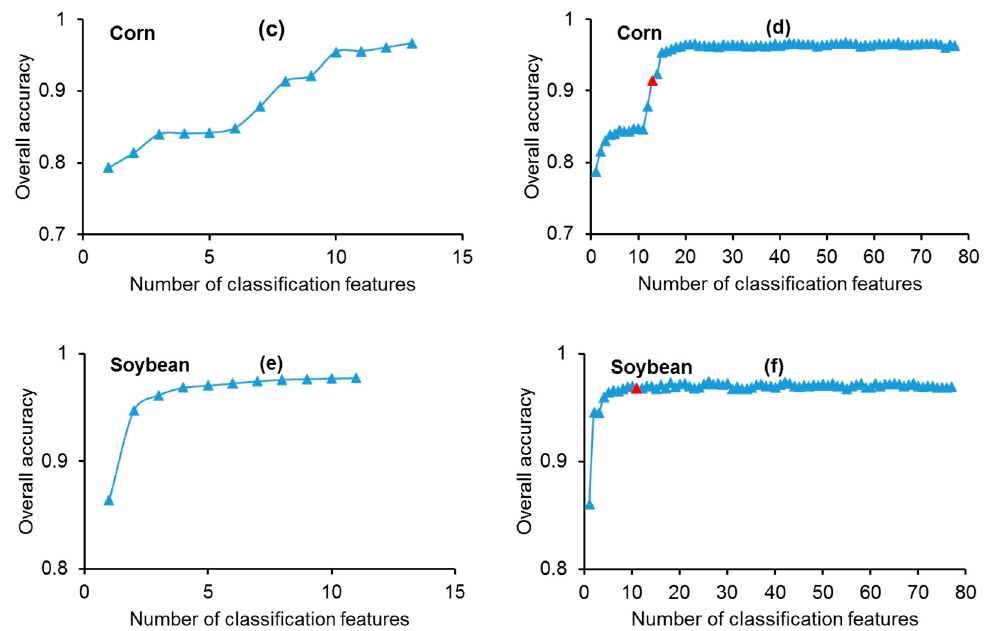
Figure 6. Classification accuracy curves of individual optimal ( a , c , e ) and unoptimized ( b , d , f ) feature sets for rice, corn, and soybean. The red triangles in ( b , d , f ) correspond to the same number of features with the maximum global separability values as the number of optimal features ( a , c , e ).